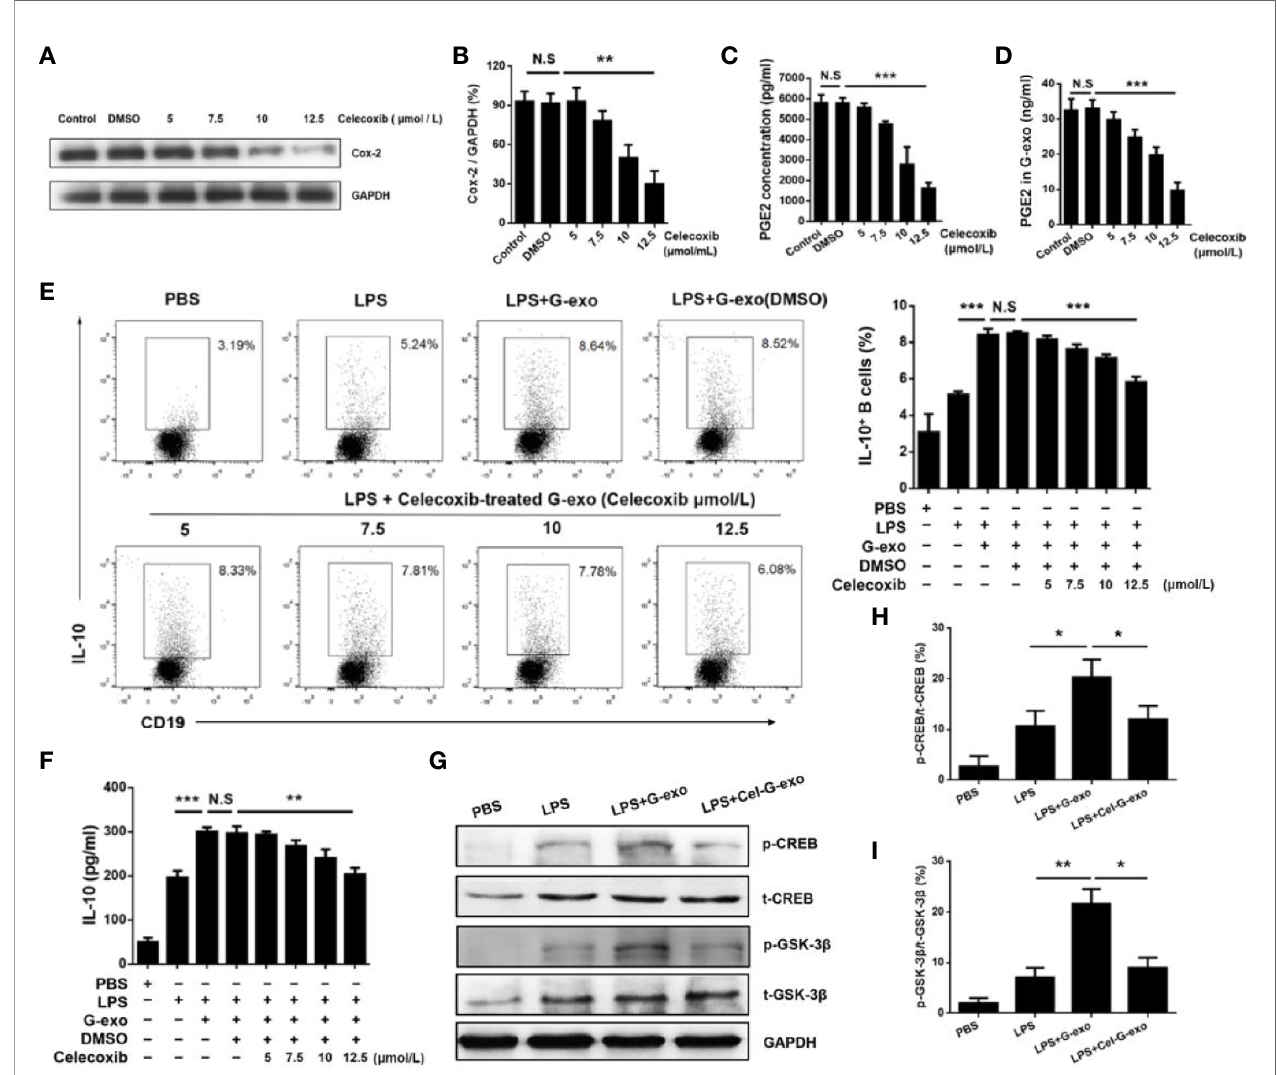
FIGURE 5 | G-MDSC exosomal PGE2 promotes IL-10 + B cells (A) COX-2 expression in G-MDSCs was detected after treatment with the COX-2 inhibitor celecoxib. (B) The ratio of COX2 and GAPDH in each group was statistically analyzed. (C) The level of PGE2 in the G-MDSC culture supernatant treated with celecoxib was detected by ELISA. (D) The level of PGE2 in the G-exo treated with celecoxib was detected by ELISA. (E) IL-10 – producing B cells after treatment with celecoxib- treated G-exo in the present of LPS were analyzed by fl ow cytometry. (F) The level of IL-10 in culture supernatant after treatment with celecoxib-treated G-exo was detected by ELISA. (G) The p-GSK-3 b , T-GSK-3 b , p-CREB, and T-CREB were detected by Western blot analysis. (H) The ratio of p-CREB and T-CREB in each group was statistically analyzed. (I) The ratio of p-GSK-3 b and T-GSK-3 b in each group was statistically analyzed. Bar graphs show the means ± SD. *P < 0.05; **P < 0.01; ***P < 0.001; ns: indicates no signi fi